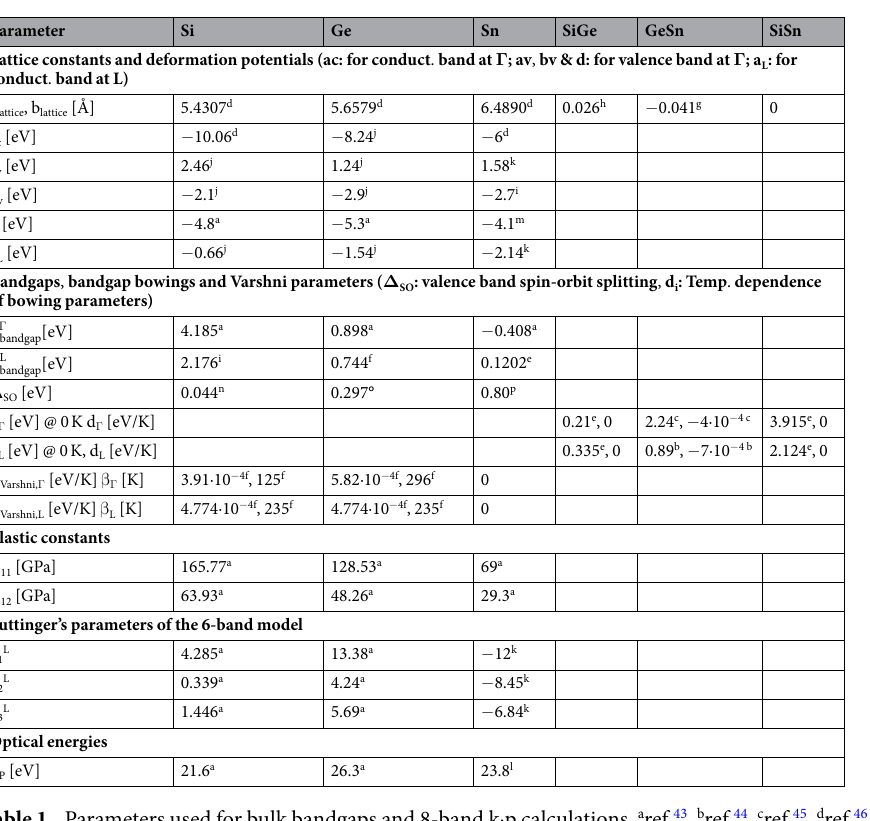
Table 1. Parameters used for bulk bandgaps and 8-band k·p calculations. a ref. 43 , b ref. 44 , c ref. 45 , d ref. 46 , e ref. 47 ,